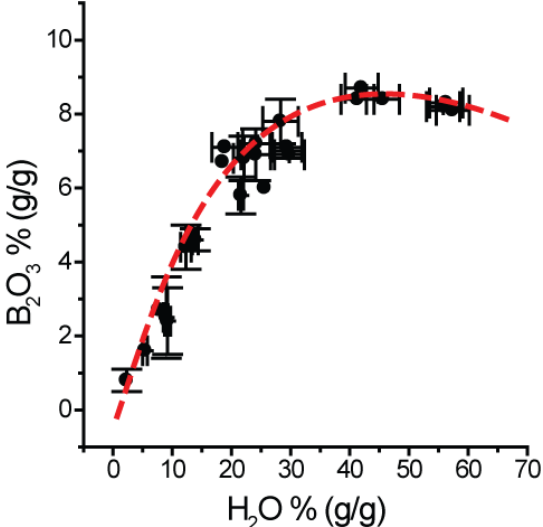
Figure 5. Correlation between water and B from the Malkhan